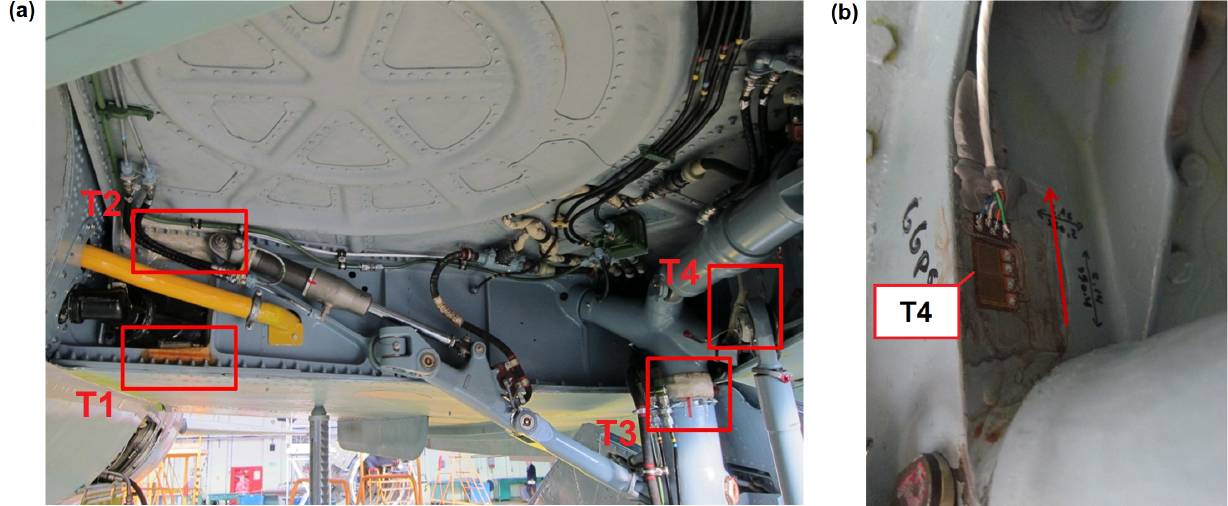
Figure 6. Reduced system for load monitoring: ( a ) general location of strain gauges of the system (left MLG bay) and ( b ) view of T4 sensor with indication of measurement